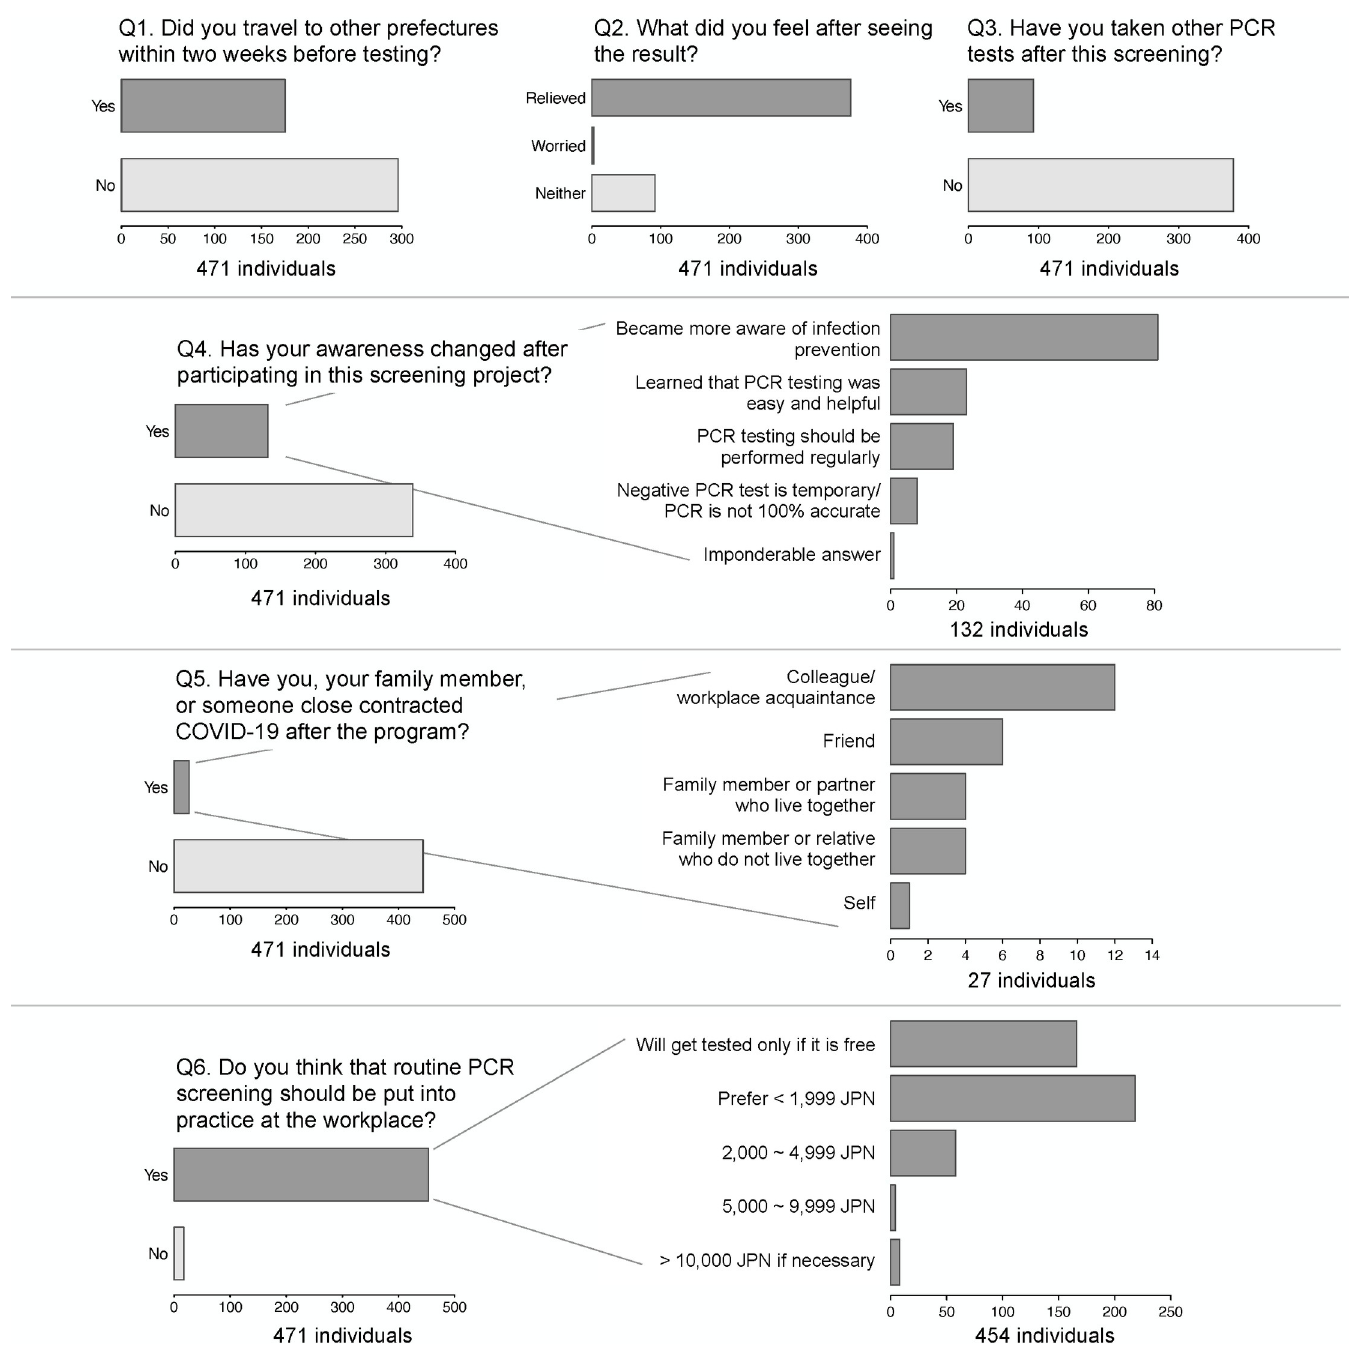
Fig 4. Responses to the online survey. Plots were generated using the survey result (S2